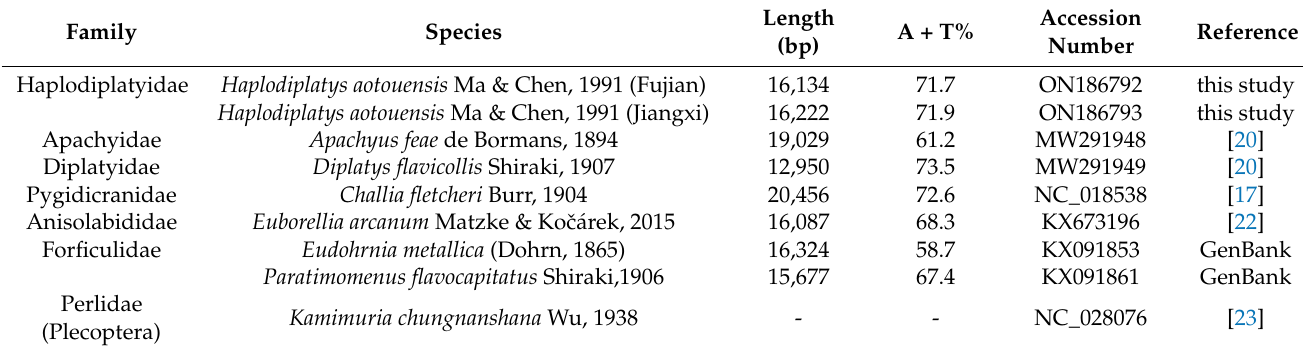
Table 1. List of species used in this